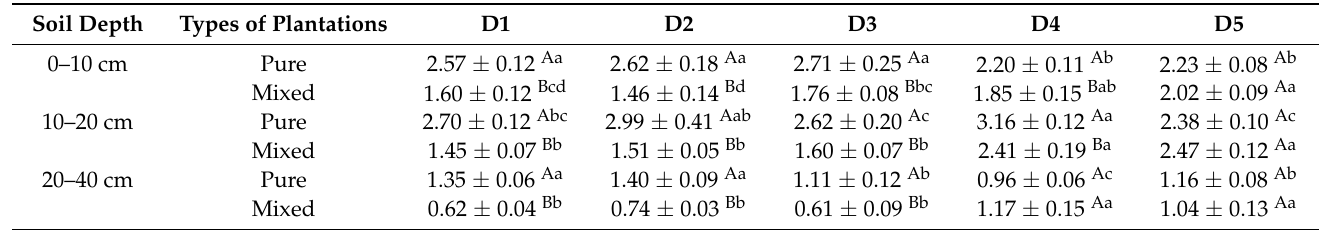
Table 2. The P activation coefficient at different soil sampling points for the pure larch plantation and mixed larch–ash plantation (%). Lowercase letters indicate significant differences among different soil sampling points in the same plantation, p < 0.05; capital letters indicate significant differences among different plantations at the same sampling point, p < 0.05. n = 3, values are means ± standard